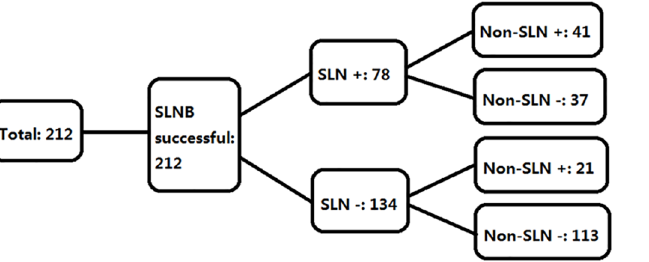
Fig 2. Overview of SLNB. SLNB = sentinel lymph node biopsy; SLN = sentinel lymph node; Non-SLN = non- sentinel lymph node.